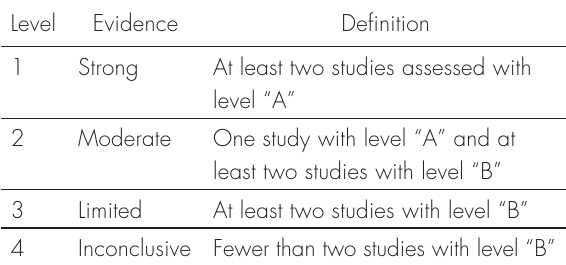
Table III. Definitions of evidence level.